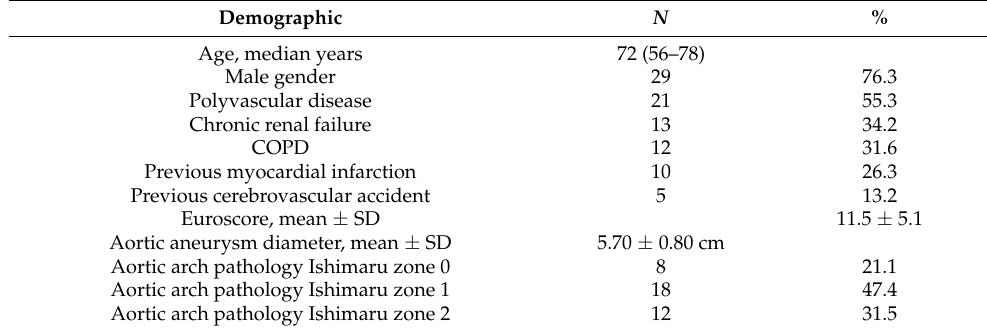
Table 1. Patient demographics and clinical risk factors (polyvascular disease: one or more claudica- tion, carotid occlusion or >50% stenosis, previous or planned intervention on the abdominal aorta, limb arteries or carotids; COPD: chronic obstructive pulmonary